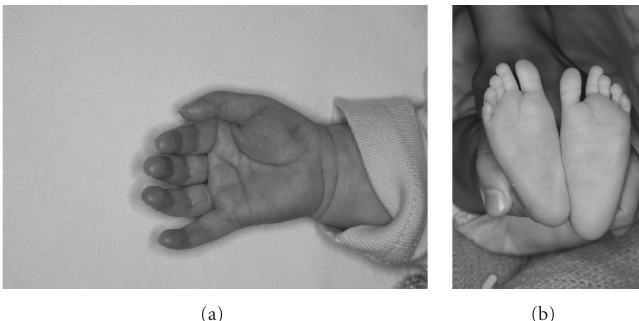
Figure 2: (a) Foetal alcoholic syndrome: right hand, note the “hockey stick” appearance of the deep palmar crease. (b) Feet, note the wide 1-2 sandal gap